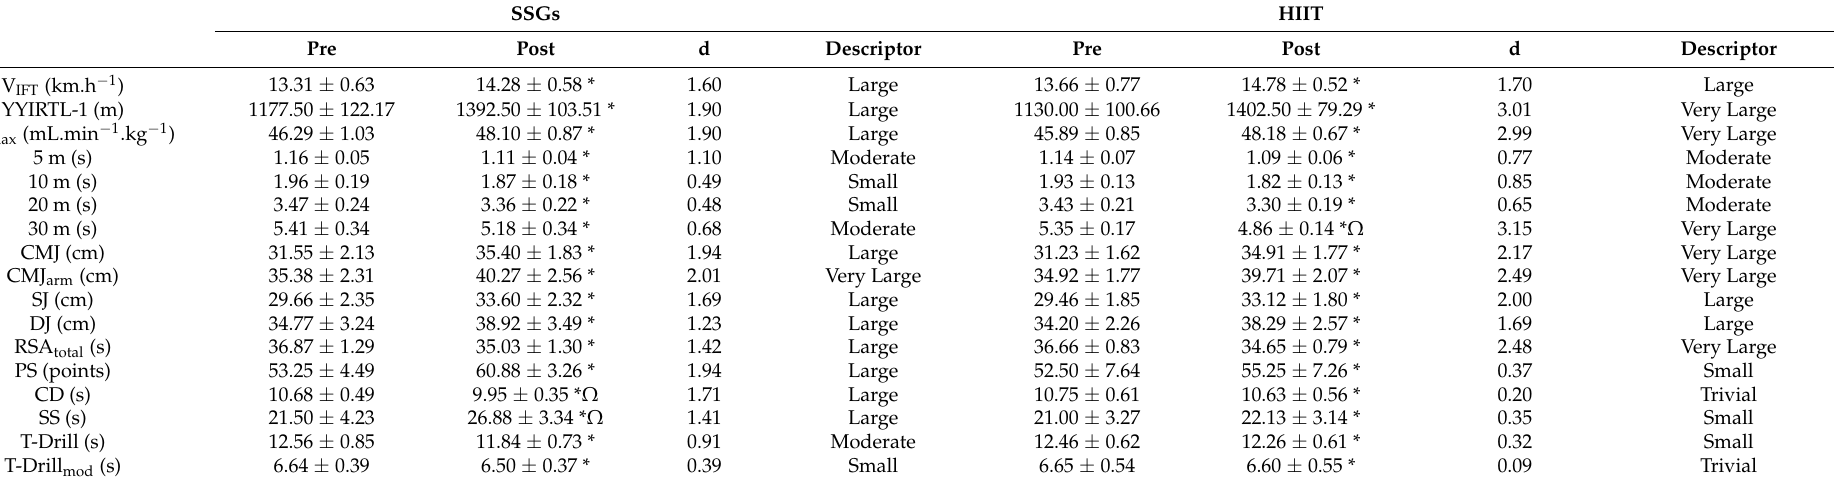
Table 2. Effect of both training methods on performance responses of the